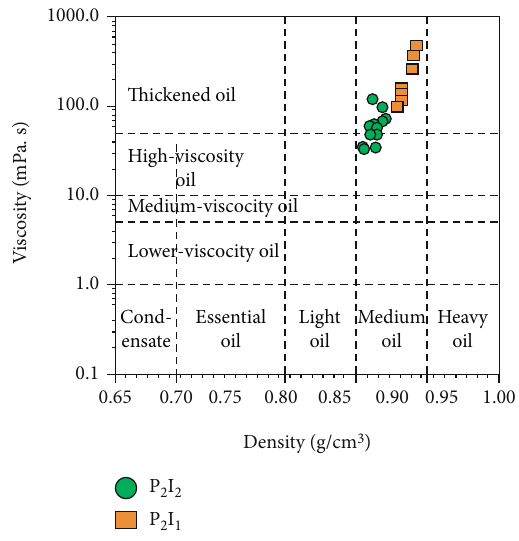
Figure 3: Cross-plots of density versus viscosity.